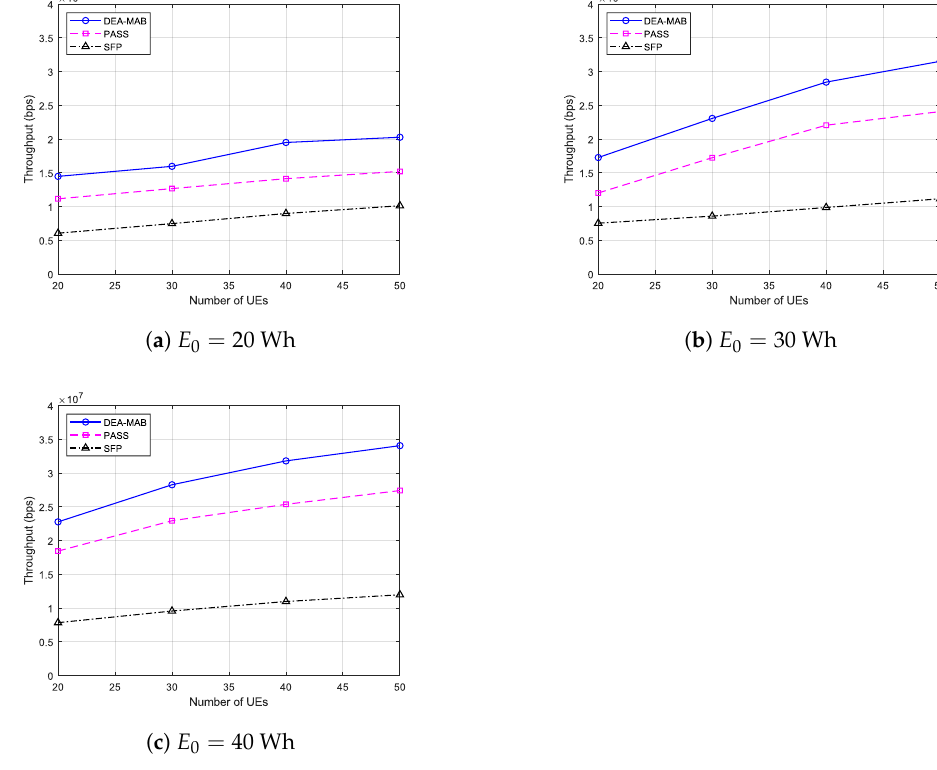
Figure 3. The DEA-MAB algorithm’s throughput versus the number of